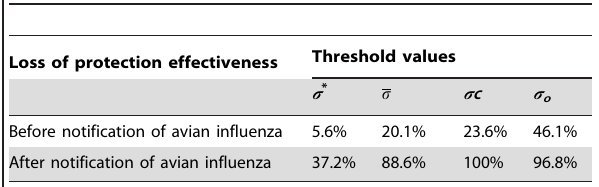
Table 3. Threshold values of the loss of protection effectiveness of the